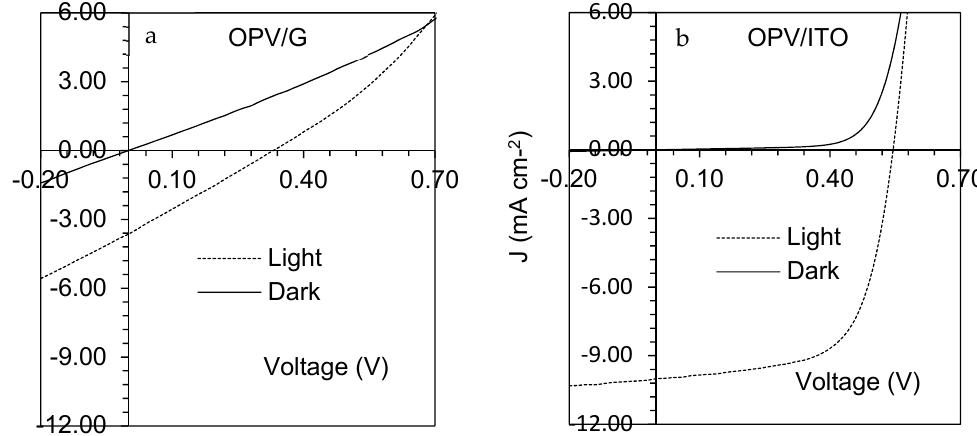
Figure 4. Current density–voltage (J-V) characteristics of OPV cells made from P3HT: PC 61 BM blend films, based on ( a ) graphene thin film and ( b ) ITO.